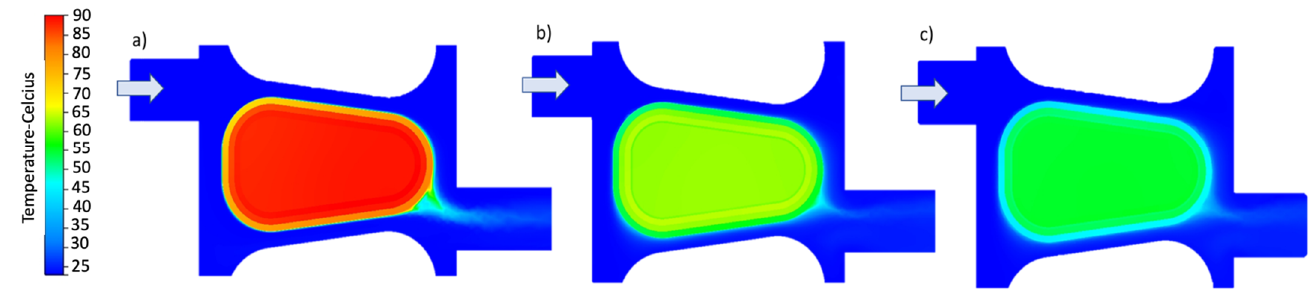
Figure 7. Temperature profiles for ( a ) conventional concentrated windings with three layers, ( b ) a new construction with the heat sink mounted on the SMC iron, ( c ) new construction with the heat sink mounted between the 1st and 2nd layers. The results are for iron losses of 11 W and copper losses of 47 W.